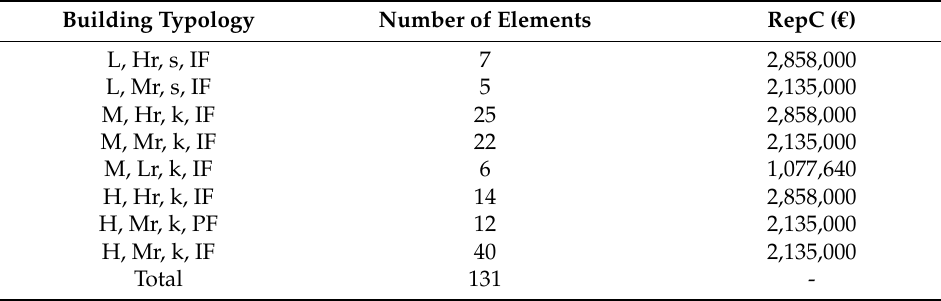
Table 4. Prevalent building typologies distribution on the examined